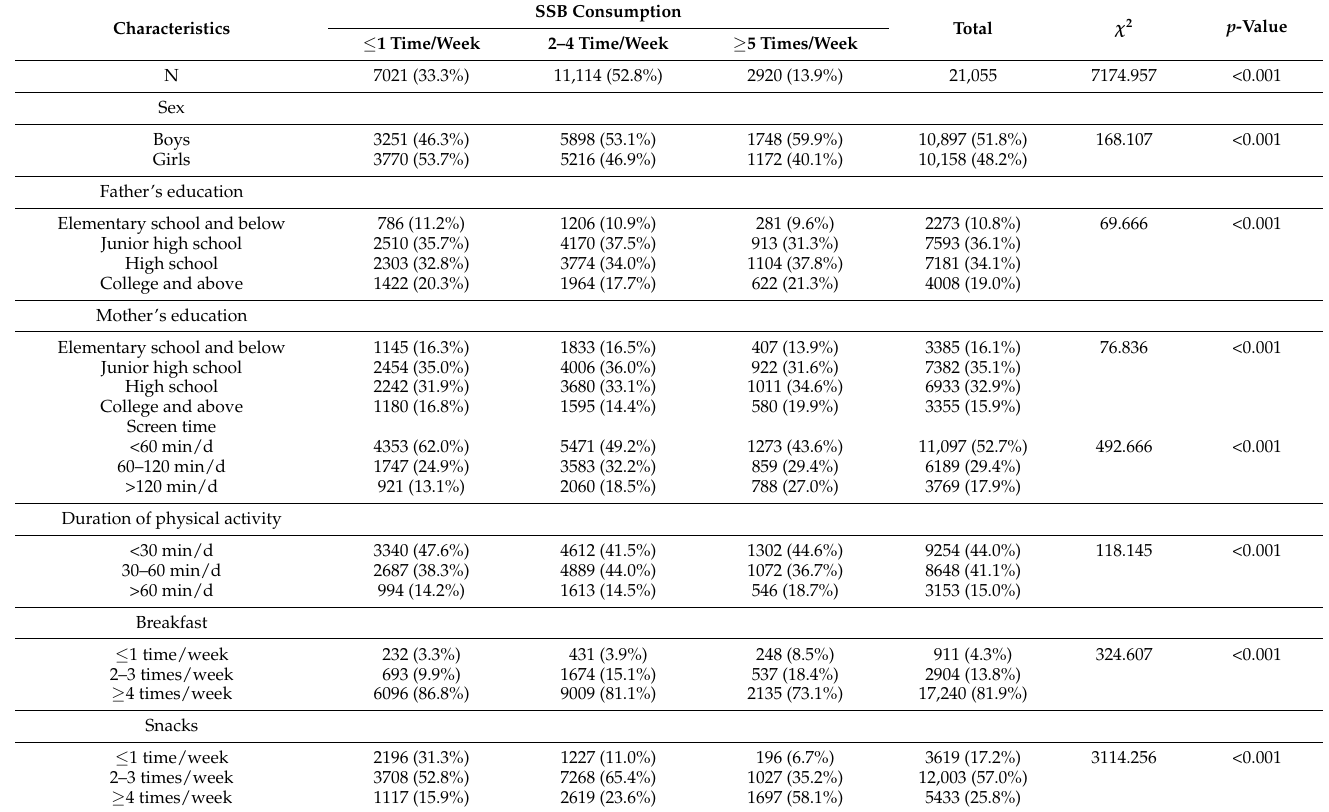
Table 1. Percentage of SSB consumption among children with different characteristics in